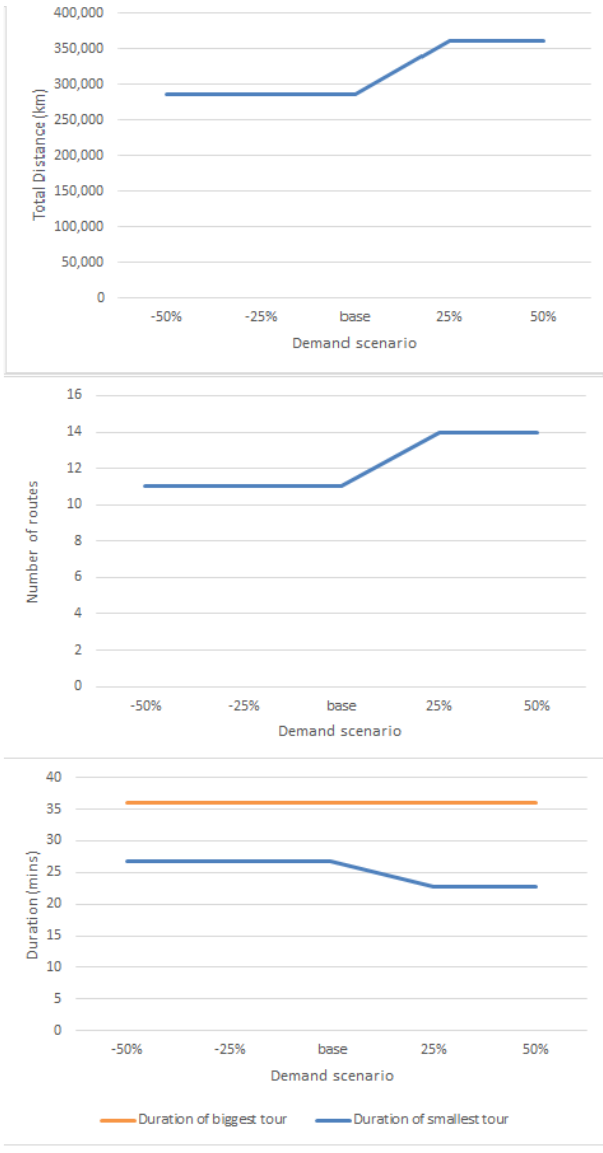
Figure 7. demand reductions up to 50% have no impact on the generated results. This happens because demand values are relatively small due to capacity thresholds while rounding is also performed. On the other hand, as demand increases, both the number of routes and the total distance increase, yet there is no difference between an increase of 25% or an increase of 50%. For both cases, 14 routes suffice for serving customers. This once again happens due to the rounding of resulting values when these are higher than vehicle capacity. However, the duration of the largest tour drops for higher demand values by approximately 15%.